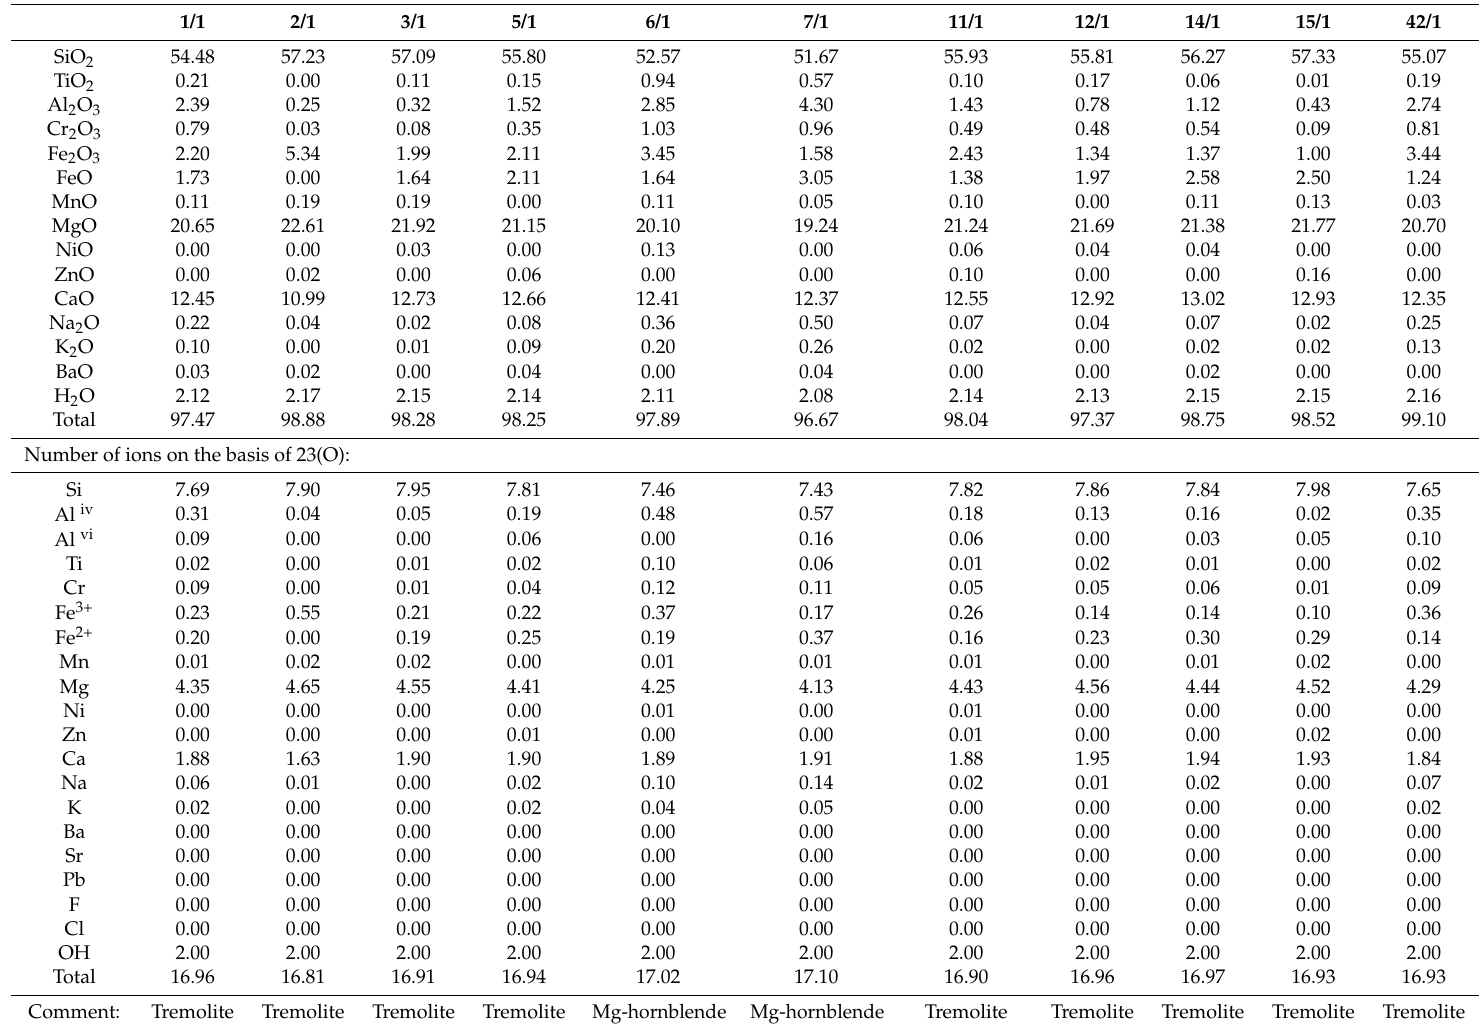
Table 2. Mineral composition of the amphibole phases present in the Holenarsipur